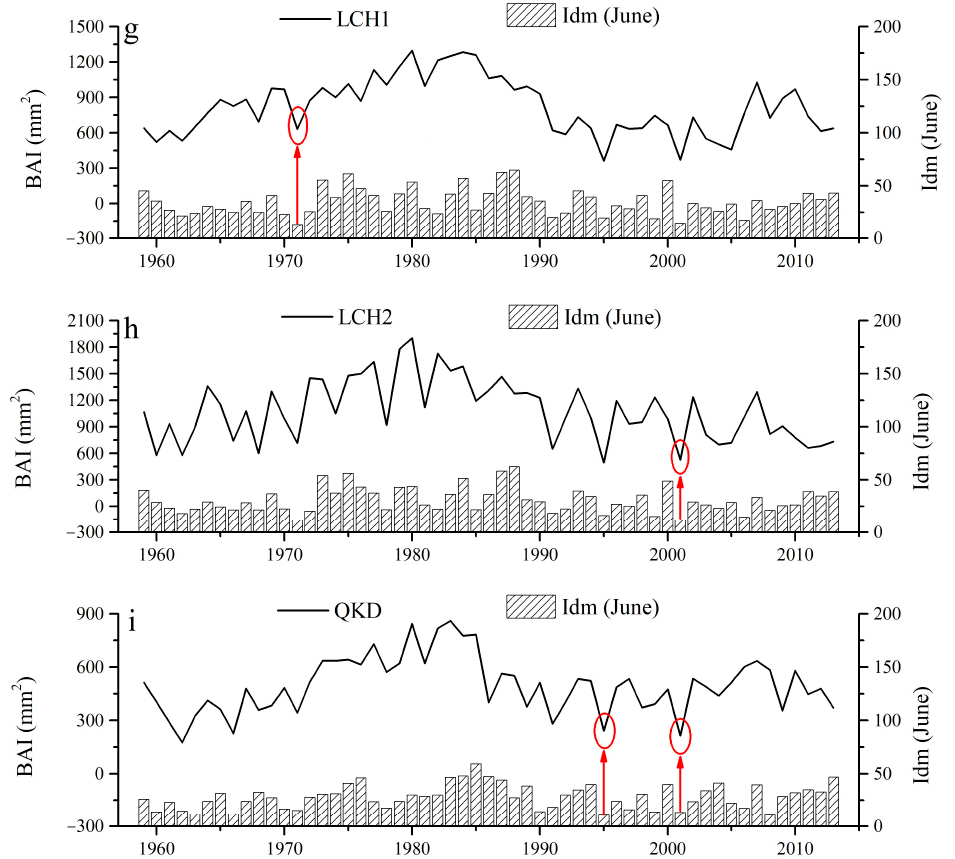
Figure 4. Growth patterns presented by the mean basal area increment (BAI) and the corresponding de Martonne aridity index (Idm) at TLG1 ( a ), TLG2 ( b ), SDL1 ( c ), SDL2 ( d ), SDL3 ( e ), SDL4 ( f ), LCH1 ( g ), LCH2 ( h ) and QKD ( i ) (the radial growth in di ff erent moisture conditions usually di ff er with each other significantly. In order to highlight the extreme low values better, we set di ff erent BAI scales in the sub-figures). TLG1 (Tulugou), TLG2, SDL1 (Sidalong), SDL2, SDL3, SDL4, LCH1 (Longchanghe),